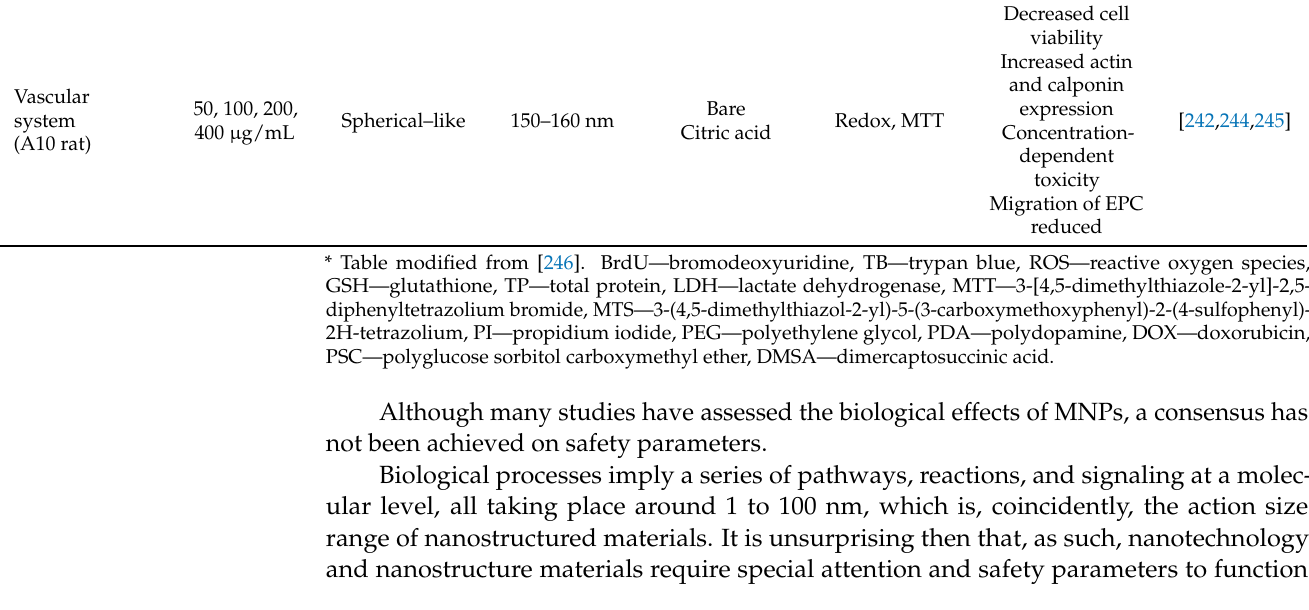
* Table modified from [246]. BrdU—bromodeoxyuridine, TB—trypan blue, ROS—reactive oxygen species, GSH—glutathione, TP—total protein, LDH—lactate dehydrogenase,